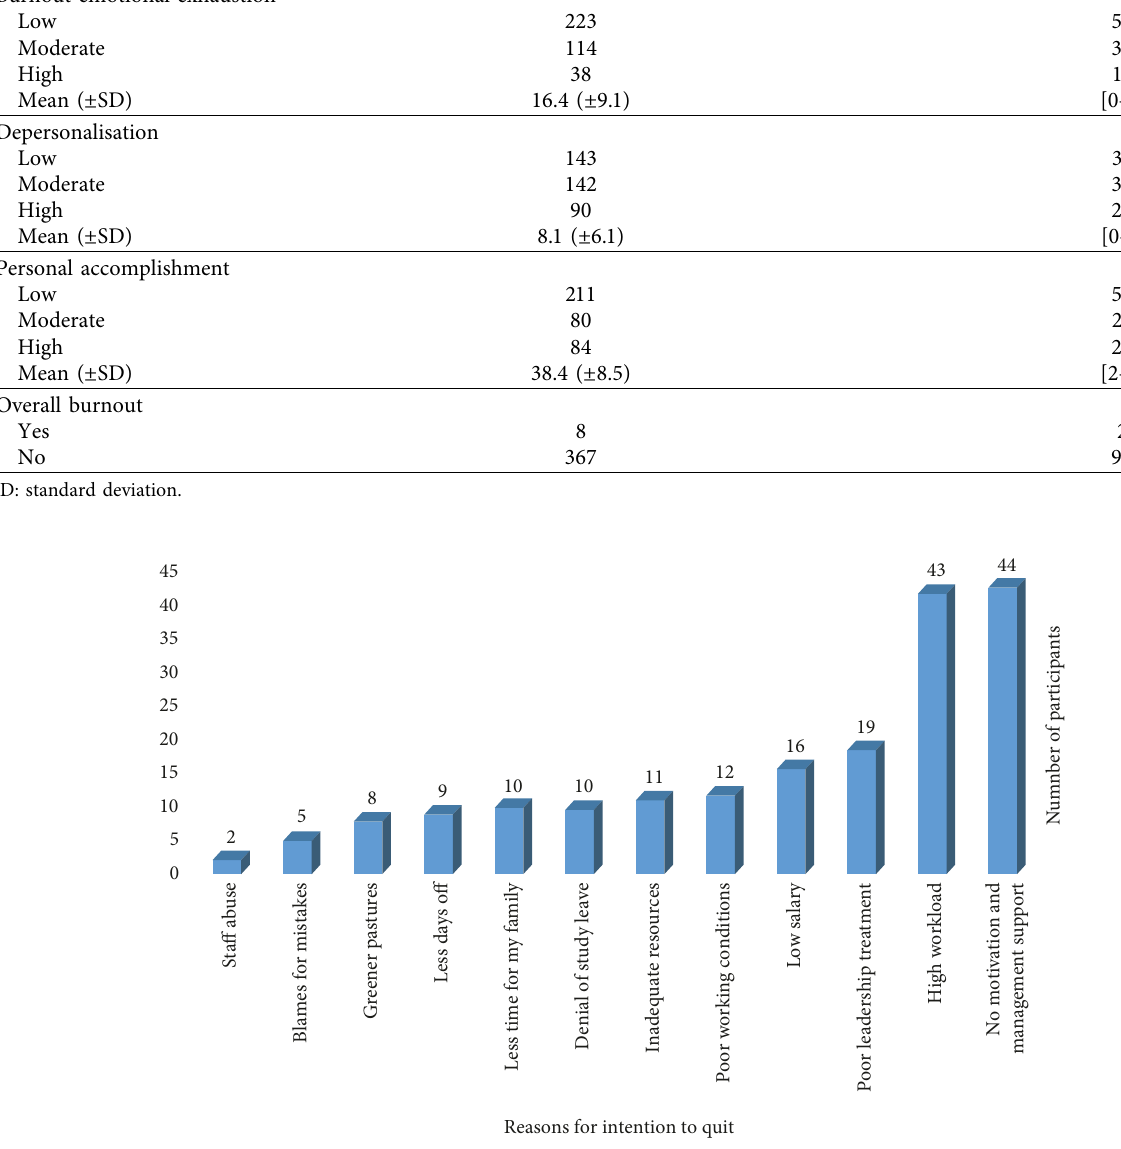
Figure 1: Reasons for intention to quit the profession among study